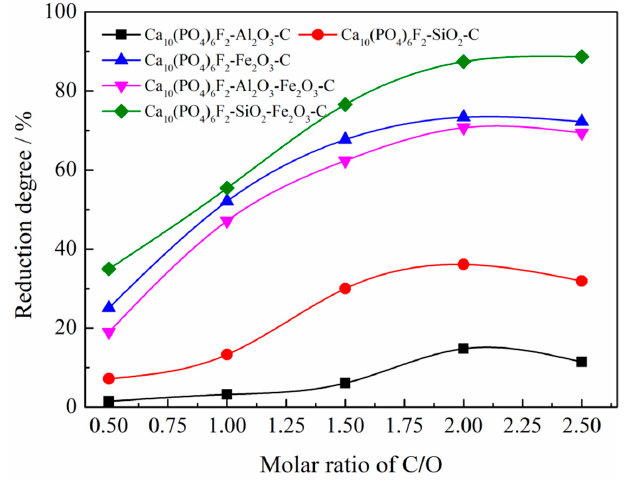
Figure 4. Effect of reduction temperature on the reduction degree of fluorapatite. Figure 4. E ff ect of reduction temperature on the reduction degree of fluorapatite.